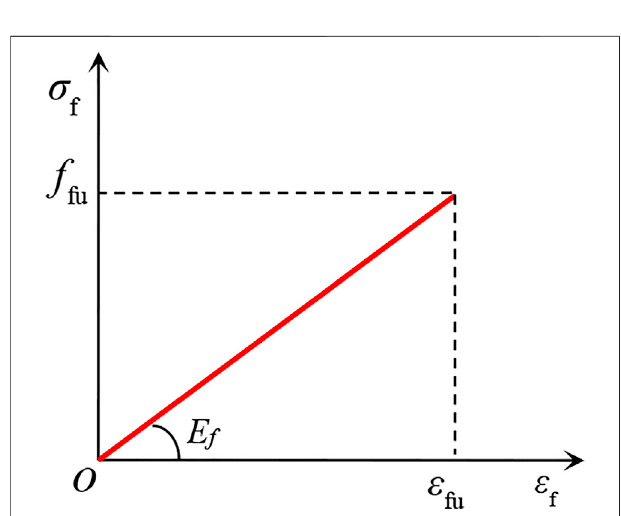
FIGURE 1 | Hollow GFRP pipe-concrete-steel tube composite long columns. FIGURE 2 | Constitutive model of GFRP